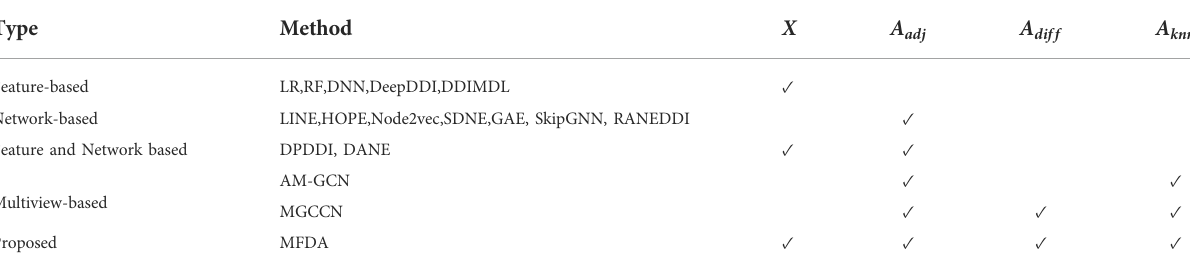
TABLE 3 Baseline method settings.